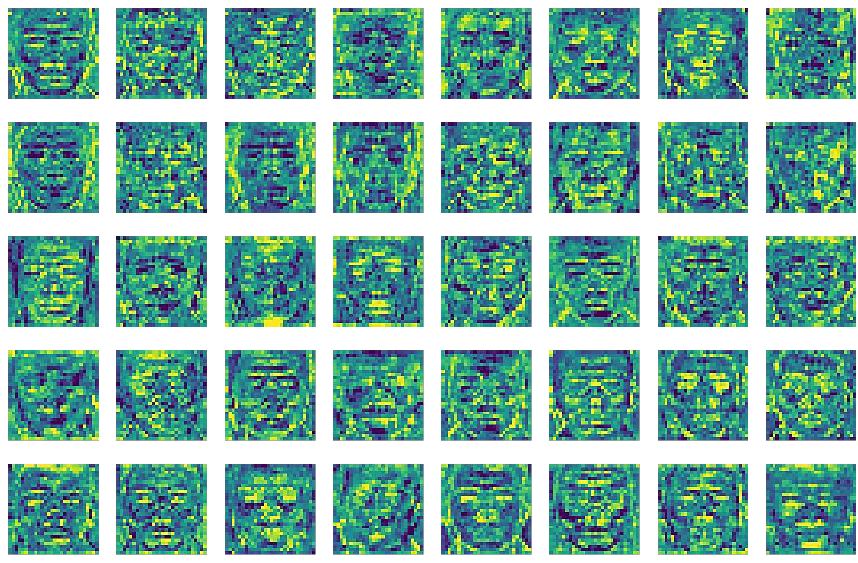
Figure 5. Output feature map of Efficient-ME (tr3).